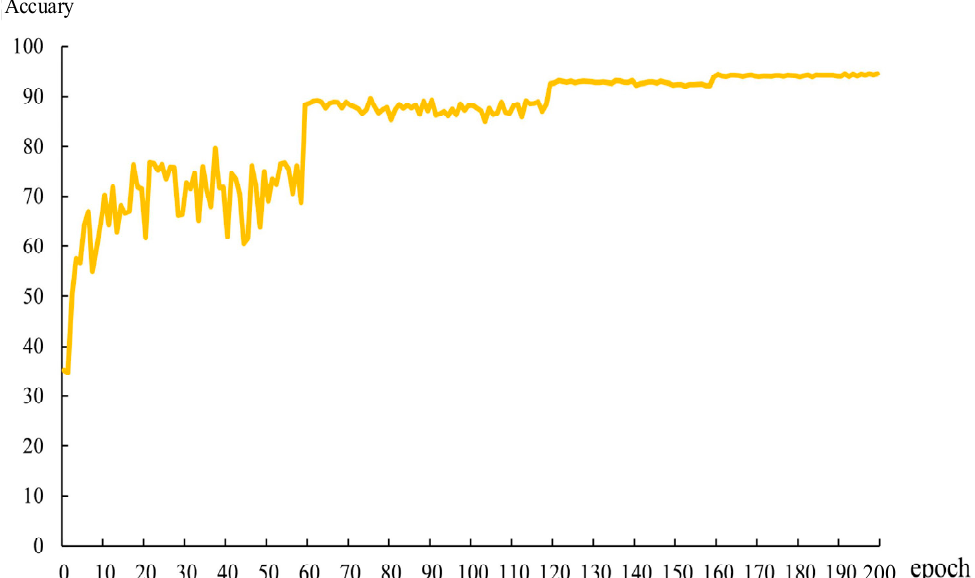
Figure 6. Accuracy curve on test set.